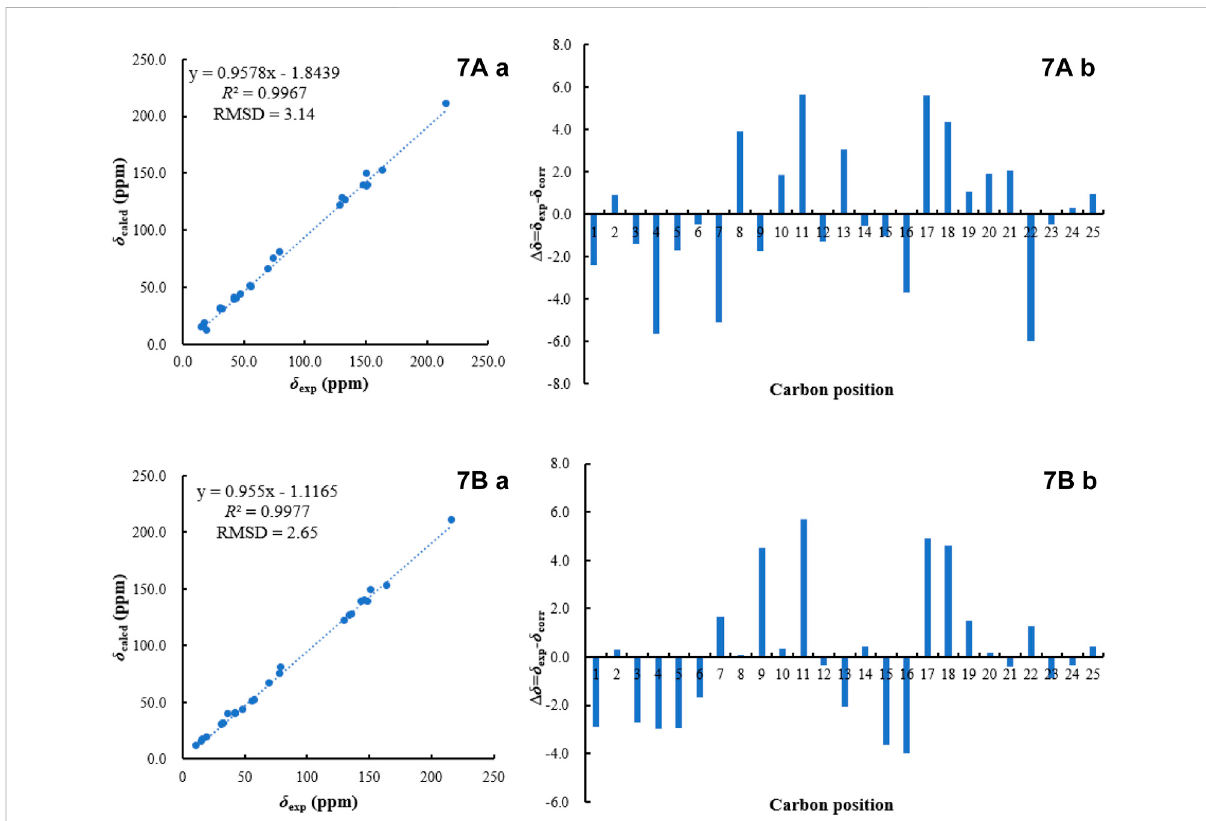
FIGURE 6 13 CNMRcalculationresultsoftwopossibleisomersof 7(A) :Linearcorrelationplotsofpredictedversusexperimental 13 CNMRchemicalshift. (B) Relative errors between the predicted δ C of two potential structures and recorded δ C.